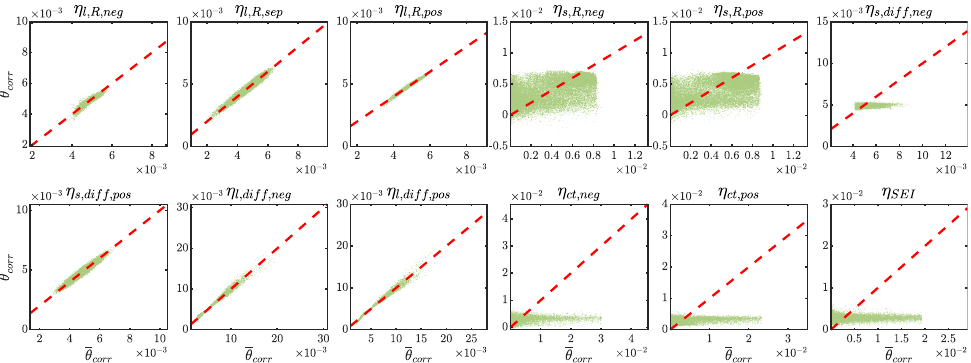
Figure 5. Results of parameter correlation for case 1. It can be observed that all processes except the conduction in the solid phase, the solid diffusion in the anode, and the interfacial processes are correlated with each other in different parameter